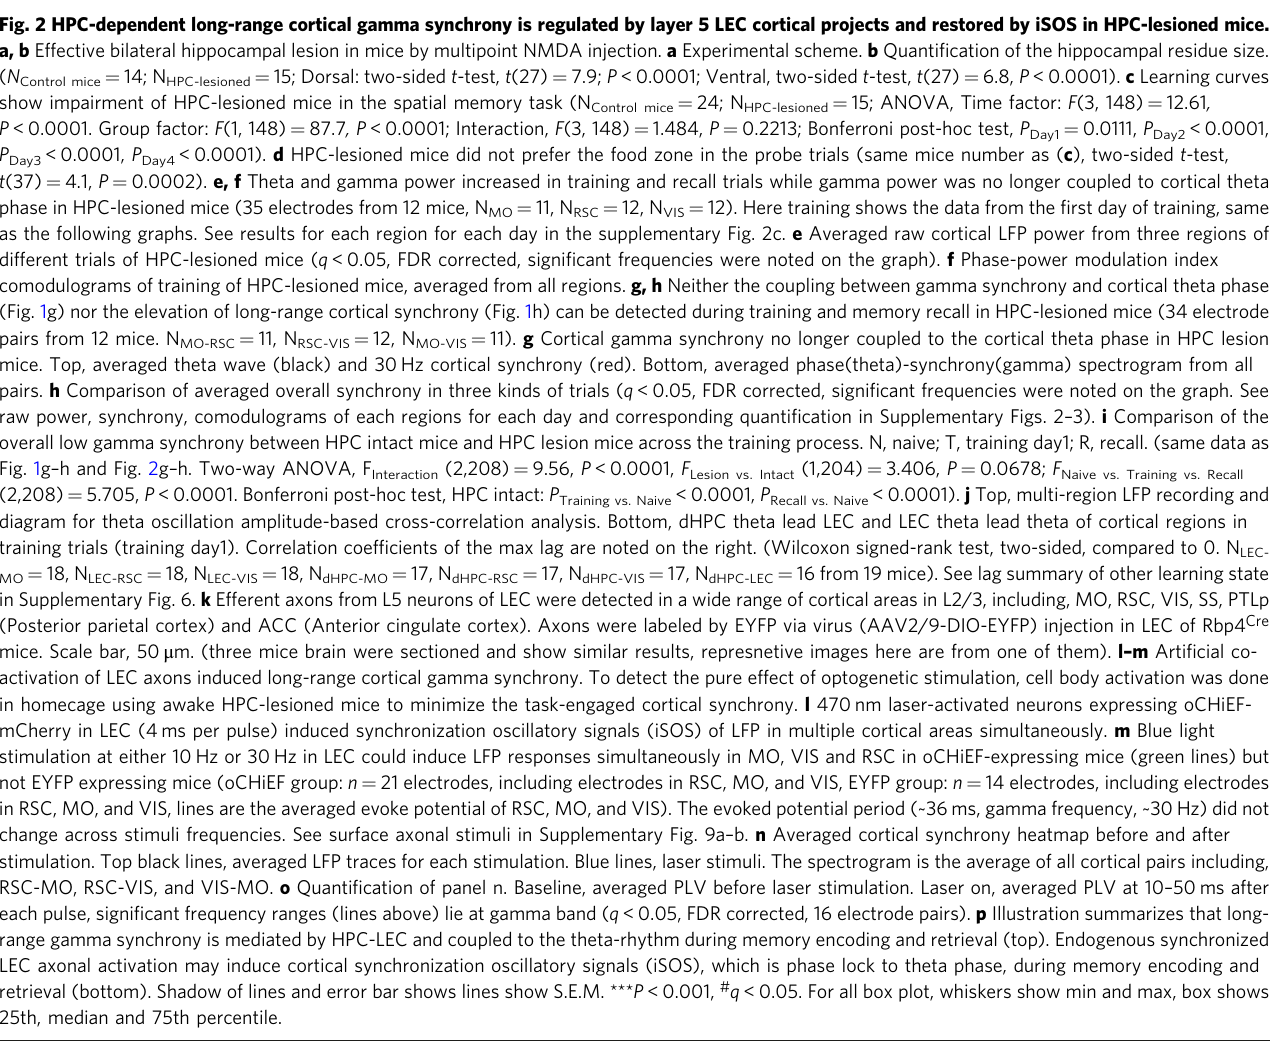
Fig. 2 HPC-dependent long-range cortical gamma synchrony is regulated by layer 5 LEC cortical projects and restored by iSOS in HPC-lesioned mice. a, b Effective bilateral hippocampal lesion in mice by multipoint NMDA injection. a Experimental scheme. b Quanti fi cation of the hippocampal residue size. ( N Control mice = 14; N HPC-lesioned = 15; Dorsal: two-sided t -test, t (27) = 7.9; P < 0.0001; Ventral, two-sided t -test, t (27) = 6.8, P < 0.0001). c Learning curves show impairment of HPC-lesioned mice in the spatial memory task (N Control mice = 24; N HPC-lesioned = 15; ANOVA, Time factor: F (3, 148) = 12.61 , P < 0.0001. Group factor: F (1, 148) = 87.7 , P < 0.0001; Interaction, F (3, 148) = 1.484, P = 0.2213; Bonferroni post-hoc test, P = 0.0111, P Day1 Day2 < 0.0001, P P t -test, Day3 < 0.0001, Day4 < 0.0001). d HPC-lesioned mice did not prefer the food zone in the probe trials (same mice number as ( c ), two-sided t as the following graphs. See results for each region for each day in the supplementary Fig. 2c. e Averaged raw cortical LFP power from three regions of different trials of HPC-lesioned mice ( q < 0.05, FDR corrected, signi fi cant frequencies were noted on the graph). f Phase-power modulation index comodulograms of training of HPC-lesioned mice, averaged from all regions. g, h Neither the coupling between gamma synchrony and cortical theta phase (Fig. 1g) nor the elevation of long-range cortical synchrony (Fig. 1h) can be detected during training and memory recall in HPC-lesioned mice (34 electrode pairs from 12 mice. N MO-RSC = 11, N RSC-VIS = 12, N MO-VIS = 11). g Cortical gamma synchrony no longer coupled to the cortical theta phase in HPC lesion mice. Top, averaged theta wave (black) and 30 Hz cortical synchrony (red). Bottom, averaged phase(theta)-synchrony(gamma) spectrogram from all pairs. h Comparison of averaged overall synchrony in three kinds of trials ( q < 0.05, FDR corrected, signi fi cant frequencies were noted on the graph. See raw power, synchrony, comodulograms of each regions for each day and corresponding quanti fi cation in Supplementary Figs. 2 – 3). i Comparison of the overall low gamma synchrony between HPC intact mice and HPC lesion mice across the training process. N, naive; T, training day1; R, recall. (same data as Fig. 1g – h and Fig. 2g – h. Two-way ANOVA, F Interaction (2,208) = 9.56, P < 0.0001, F Lesion vs. Intact (1,204) = 3.406, P = 0.0678; F Naive vs. Training vs. Recall (2,208) = 5.705, P < 0.0001. Bonferroni post-hoc test, HPC intact: P Training vs. Naive < 0.0001, P Recall vs. Naive < 0.0001). j Top, multi-region LFP recording and diagram for theta oscillation amplitude-based cross-correlation analysis. Bottom, dHPC theta lead LEC and LEC theta lead theta of cortical regions in training trials (training day1). Correlation coef fi cients of the max lag are noted on the right. (Wilcoxon signed-rank test, two-sided, compared to 0. N LEC- = 18, N = 18, N = 18, N = 17, N = 17, N = 17, N = 16 from 19 mice). See lag summary of other learning state LEC-RSC LEC-VIS dHPC-MO dHPC-RSC dHPC-VIS dHPC-LEC MO in Supplementary Fig. 6. k Efferent axons from L5 neurons of LEC were detected in a wide range of cortical areas in L2/3, including, MO, RSC, VIS, SS, PTLp (Posterior parietal cortex) and ACC (Anterior cingulate cortex). Axons were labeled by EYFP via virus (AAV2/9-DIO-EYFP) injection in LEC of Rbp4 Cre mice. Scale bar, 50 μ m. (three mice brain were sectioned and show similar results, represnetive images here are from one of them). l – m Arti fi cial co- activation of LEC axons induced long-range cortical gamma synchrony. To detect the pure effect of optogenetic stimulation, cell body activation was done in homecage using awake HPC-lesioned mice to minimize the task-engaged cortical synchrony. l 470 nm laser-activated neurons expressing oCHiEF- mCherry in LEC (4 ms per pulse) induced synchronization oscillatory signals (iSOS) of LFP in multiple cortical areas simultaneously. m Blue light stimulation at either 10 Hz or 30 Hz in LEC could induce LFP responses simultaneously in MO, VIS and RSC in oCHiEF-expressing mice (green lines) but not EYFP expressing mice (oCHiEF group: n = 21 electrodes, including electrodes in RSC, MO, and VIS, EYFP group: n = 14 electrodes, including electrodes in RSC, MO, and VIS, lines are the averaged evoke potential of RSC, MO, and VIS). The evoked potential period (~36 ms, gamma frequency, ~30 Hz) did not change across stimuli frequencies. See surface axonal stimuli in Supplementary Fig. 9a – b. n Averaged cortical synchrony heatmap before and after stimulation. Top black lines, averaged LFP traces for each stimulation. Blue lines, laser stimuli. The spectrogram is the average of all cortical pairs including, RSC-MO, RSC-VIS, and VIS-MO. o Quanti fi cation of panel n. Baseline, averaged PLV before laser stimulation. Laser on, averaged PLV at 10 – 50 ms after each pulse, signi fi cant frequency ranges (lines above) lie at gamma band ( q < 0.05, FDR corrected, 16 electrode pairs). p Illustration summarizes that long- range gamma synchrony is mediated by HPC-LEC and coupled to the theta-rhythm during memory encoding and retrieval (top). Endogenous synchronized LEC axonal activation may induce cortical synchronization oscillatory signals (iSOS), which is phase lock to theta phase, during memory encoding and retrieval (bottom). Shadow of lines and error bar shows lines show S.E.M. *** P < 0.001, # q < 0.05. For all box plot, whiskers show min and max, box shows 25th, median and 75th